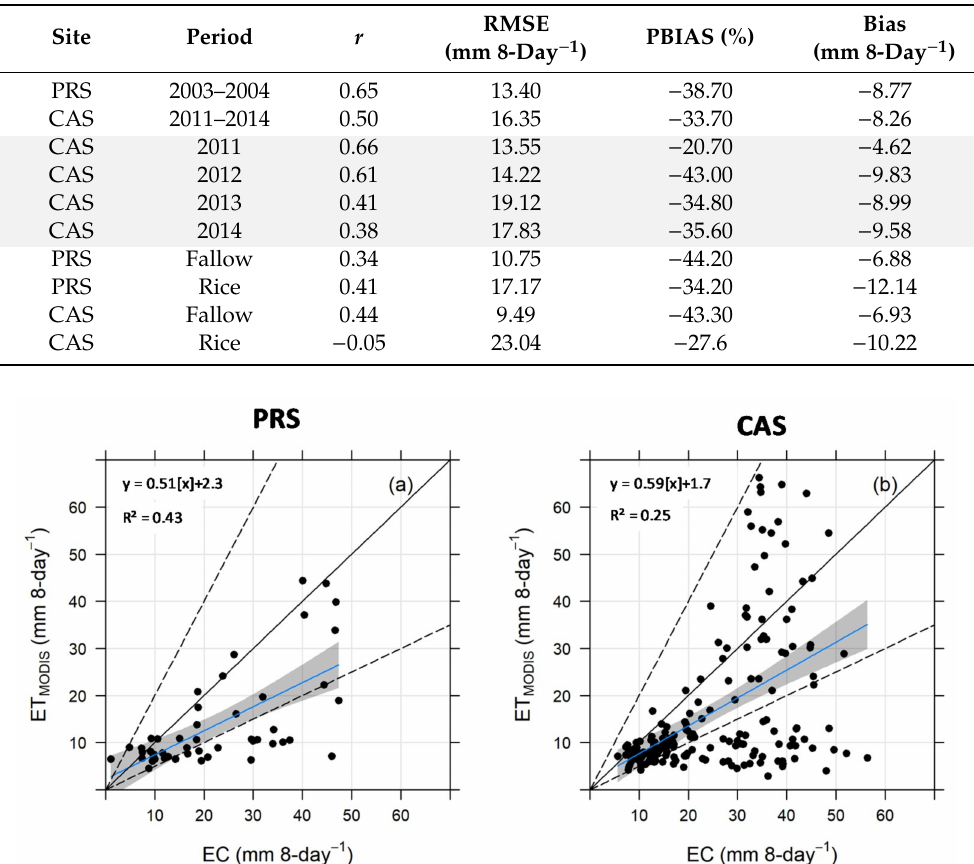
Table 3. Statistical analysis between MOD16 evapotranspiration (ET) estimates against eddy covariance (EC) measurements in two rice paddy sites located in Southern Brazil.